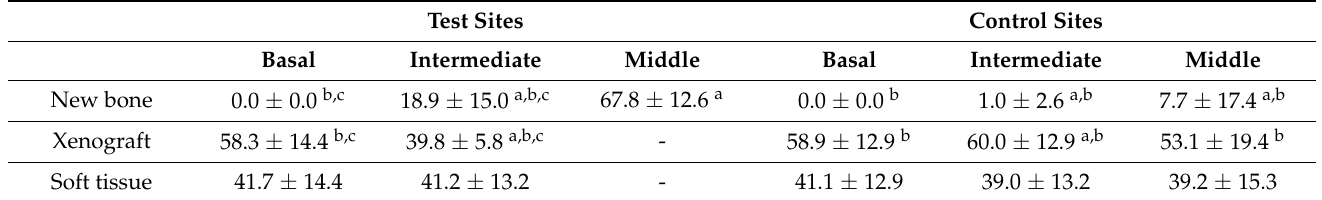
Table 1. Linear measurements. Tissues in contact with the sinus mucosa after 2 weeks of healing in the various regions evaluated. Mean values ± standard deviation in percentages. Test sites with the inward window.